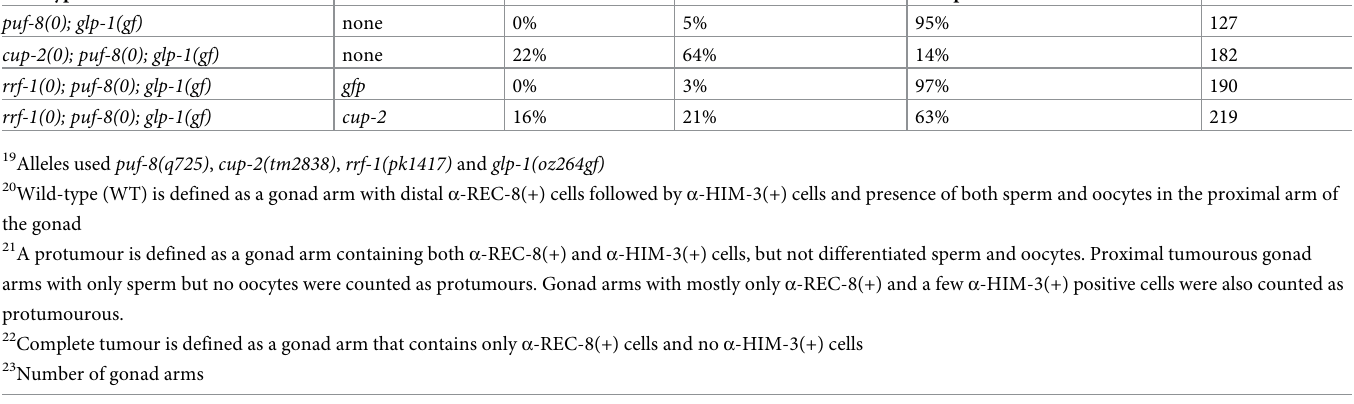
Table 4. Loss of cup-2 activity in the germline is likely responsible for tumour suppression. Genotype 19 RNAi WT 20 Protumour 21 Complete Tumour